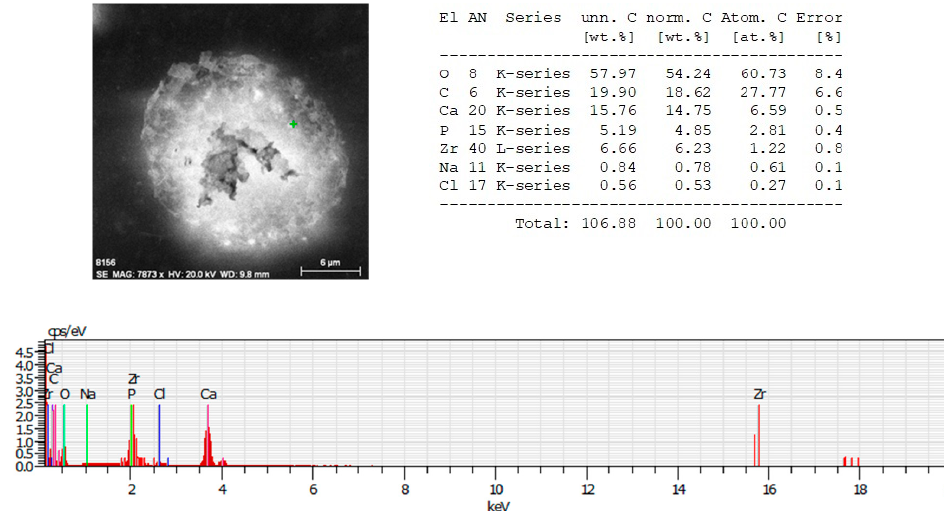
Figure 8. EDX spectrum of microstructure fabricated by femtosecond laser irradiation with N = 1, I = 1.5 × 10 15 W/cm 2 of thepolymer/ceramic composite—70% Ch/30% HAp/ZrO 2 . Table (upper right): EDX spectra showing the atomic percentages of O, C, Ca, P, Zr, Na,